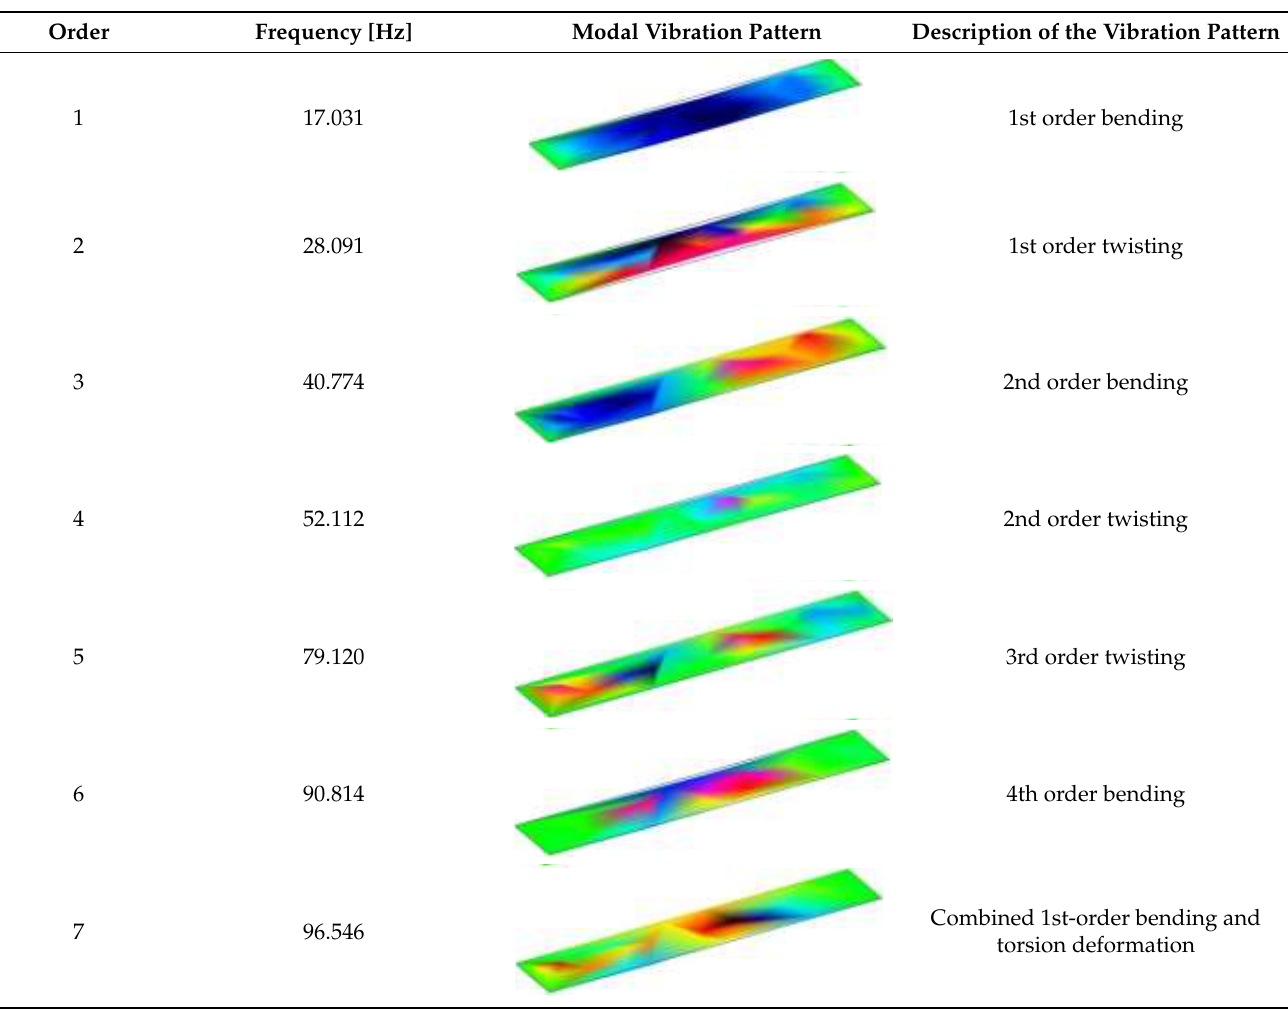
Figure 11. Bridge deck model based on the IPSOARW distribution method.